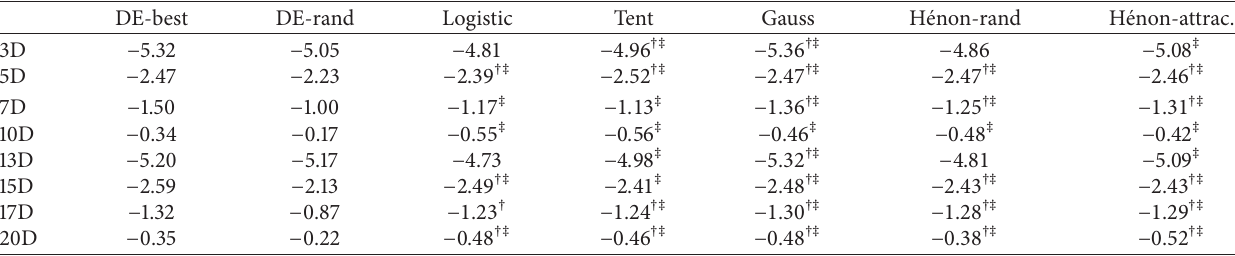
Table 8: Means of Gaussian mixture models with 3D, 5D, 7D, 10D, 13D, 15D, 17D, and 20 D. The abbreviation meanings are in Table 2. The ( † ) and ( ‡ ) marks mean that the proposed algorithms are significantly better than or as the same as IDE/best/1/bin and IDE/rand/1/bin, respectively, by Wilcoxon sign-ranked test ( 𝑃 < 0.05